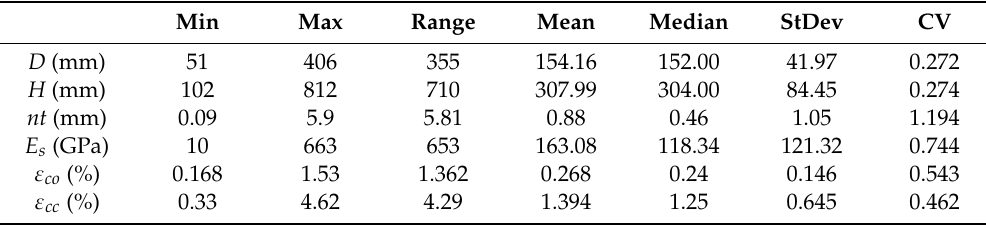
Table 3. Statistic properties of the parameters included in the constructed database of the strain model (572